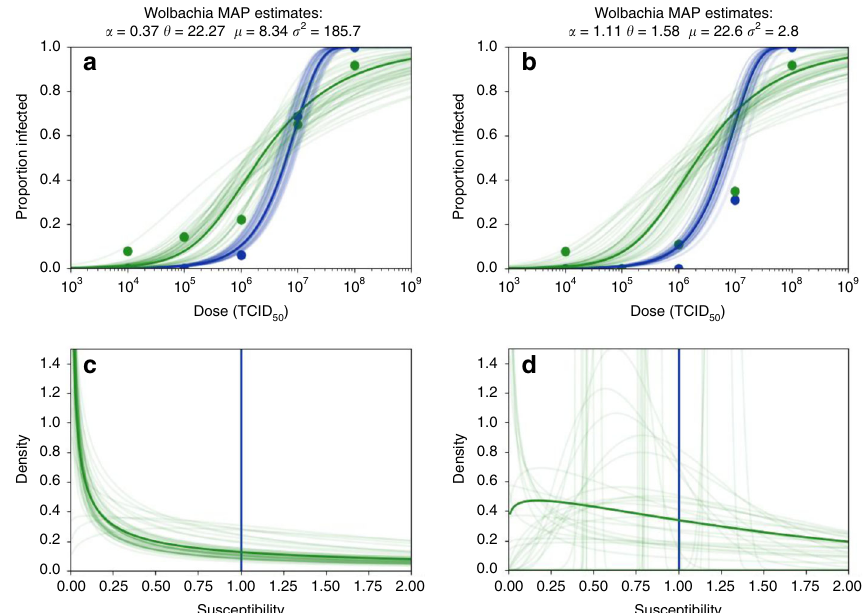
Fig. 1 Dose – response curves and associated distributions inferred under different pre-processing of data. Dose – response curves for Wolbachia -free (Wolb − , in blue) and Wolbachia-carrier (Wolb + , in green) populations given data (dots) from Rio de Janeiro, Brazil 1 . The original procedures (King et al. 3 , “ Methods ” ) are replicated in a and c , showing the bold curves of the maximum a posteriori (MAP) estimate (King et al. 3 , a , c ) and 50 random Monte Carlo Markov Chain estimates, almost all of which have the shape parameter ( α ) smaller than one, giving high densities close to zero susceptibility and a long tail towards larger values ( θ is the scale parameter). Applying an alternative threshold for false positives based on the mean cycle threshold (Ct) value of fi ve quanti fi able negative controls in the original data ( b , d ) results in less mosquitoes being classi fi ed as infected (noticeable in b ), and leads to higher estimated mean susceptibility ( μ ) for the Wolbachia group and less variance ( σ 2 ). As in King et al. 3 , these analyses exclude the fi rst time point (3 days post infection) as it may represent transient, dose-independent presence of virus rather systemic